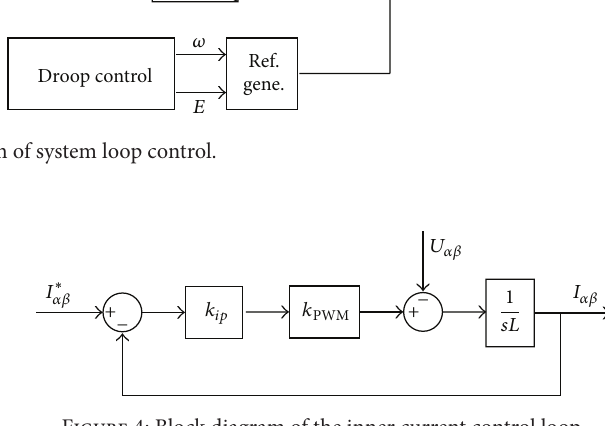
Figure 4: Block diagram of the inner current control